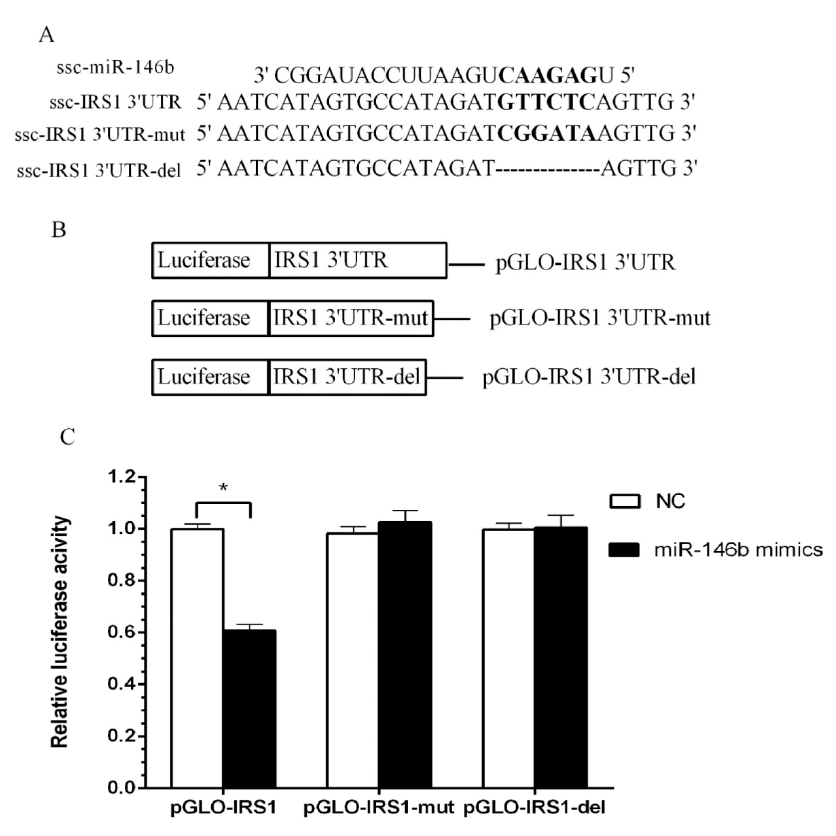
Figure 5. Verification of ssc-miR-146 direct targets of porcine IRS1 by luciferase reporter assay. ( A ) Three 3 ′ -UTR sequences containing normal, mutagenic, and deleted binding sites were inserted downstream of the luciferase reporter. Six nucleotides of IRS1 3 ′ -UTR were mutated or deleted to disrupt the binding with miR-146b seed regions. ( B ) Schematic diagram showing dual-luciferase reporter constructs of porcine IRS1 3 ′ -UTR with putative miR-146b binding site; ( C ) Constructed vectors were transfected into Hela cells with miR-146 mimics or NC. The luciferase assay results revealed significant differences between miR-146b mimic and NC groups transfected with vectors containing normal IRS1 3 ′ UTR ( n = 8, * p < 0.05).